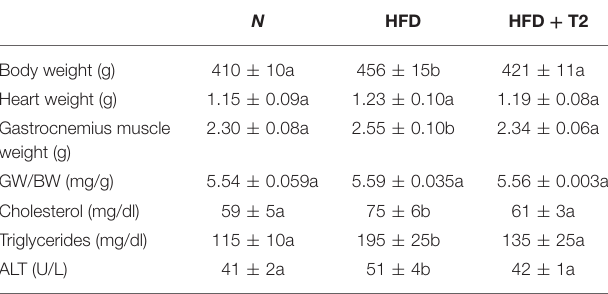
TABLE 1 | Body weight and serum parameters in N, HFD and HFD + T2